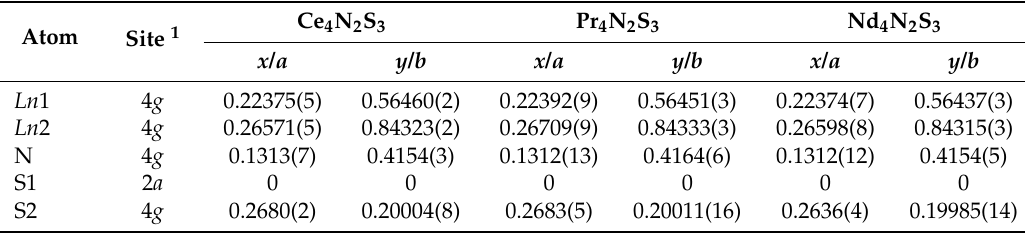
Table 2. Fractional atomic coordinates for the three members of the Ln 4 N 2 S 3 series ( Ln =